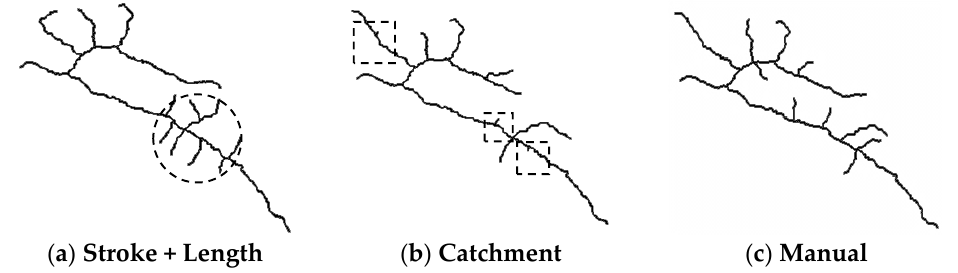
Figure 10. Generalized networks by three methods for the trellis case. ( a ) Stroke + Length; ( b ) Catchment; ( c ) Manual. Table 7. Assessment result of generalized networks in Figure 10.